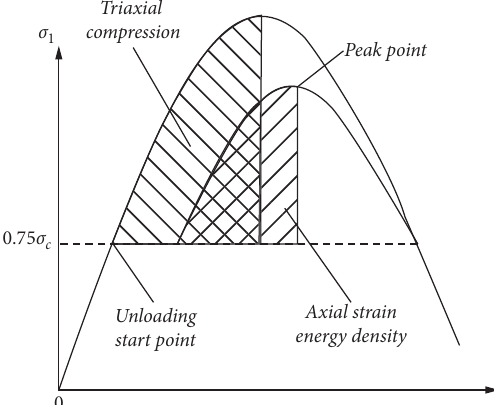
Figure 12: Schematic diagram of axial strain energy